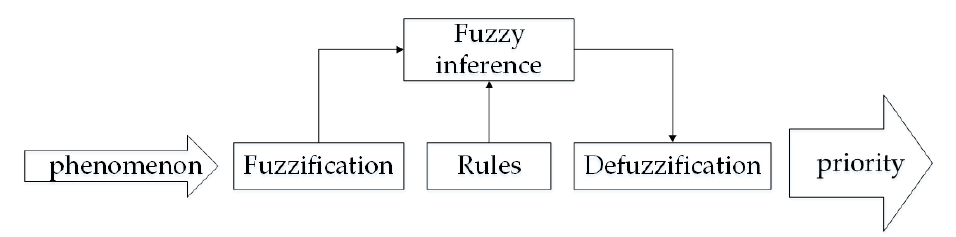
Figure 3. Flow chart of fuzzy logic reasoning (FLR) system.